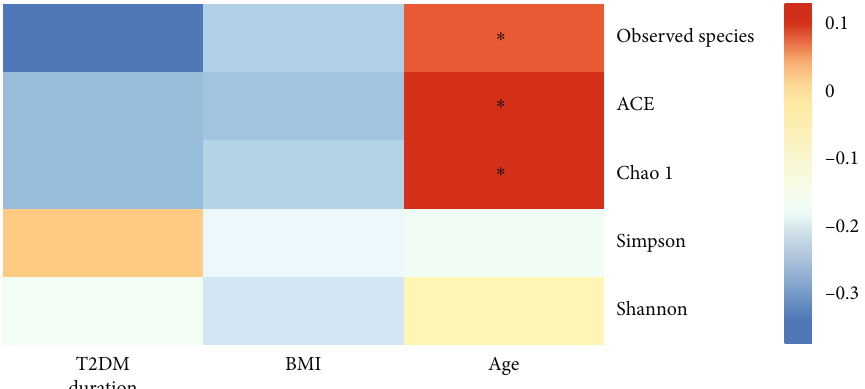
Figure 4: Correlation of alpha diversity indices with age ( n = 48 ), BMI ( n = 48 ), and diabetes duration ( n = 24 ) of the study participants. BMI: body mass index; n : number; T2DM: type 2 diabetes mellitus.